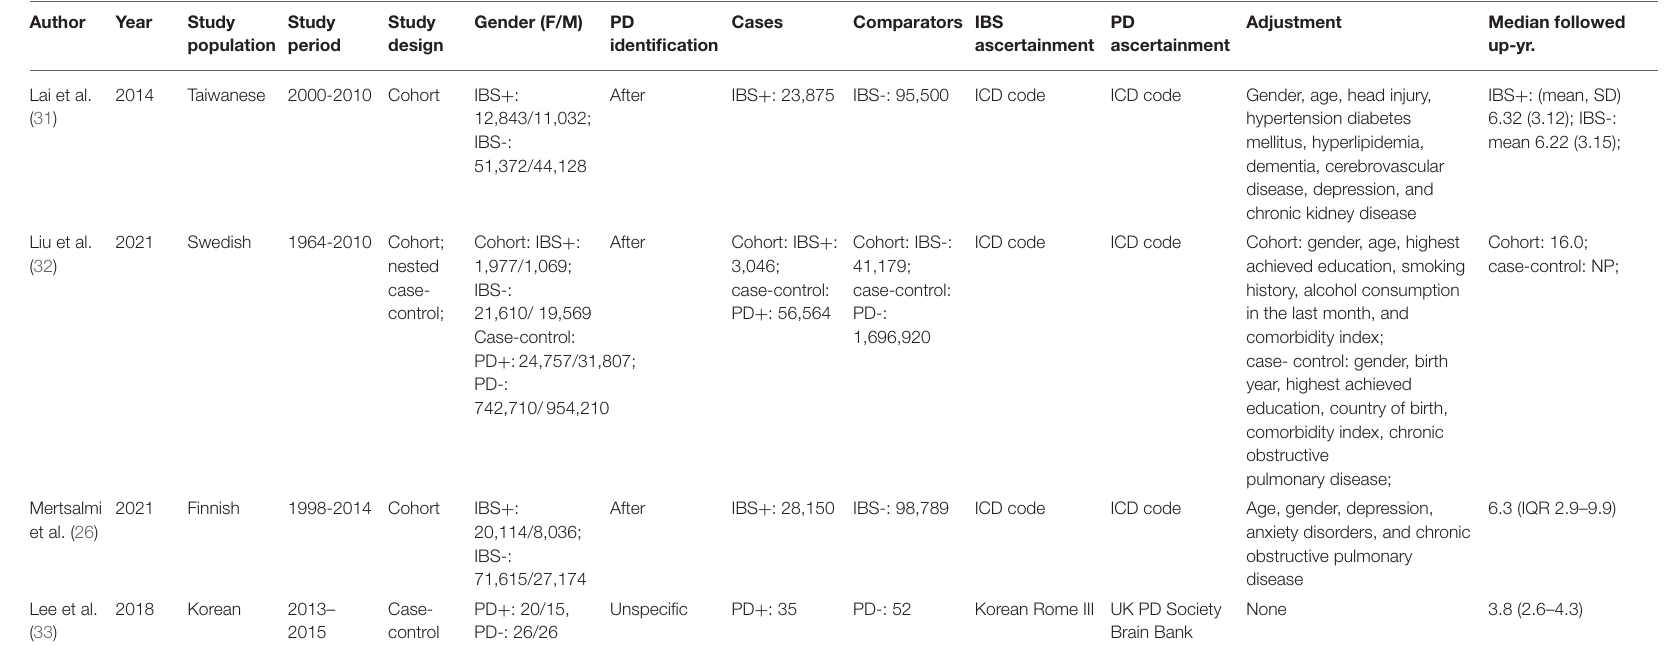
TABLE 1 | Main characteristics of the studies included in this study.